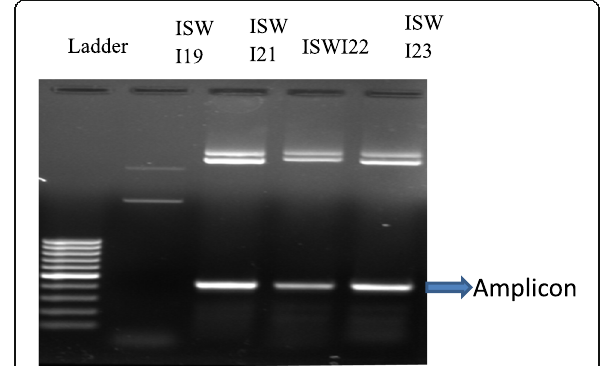
Fig. 5 1% agarose gel showing PCR confirmation of positive pAc-sgRNA-Cas9-puro-vector